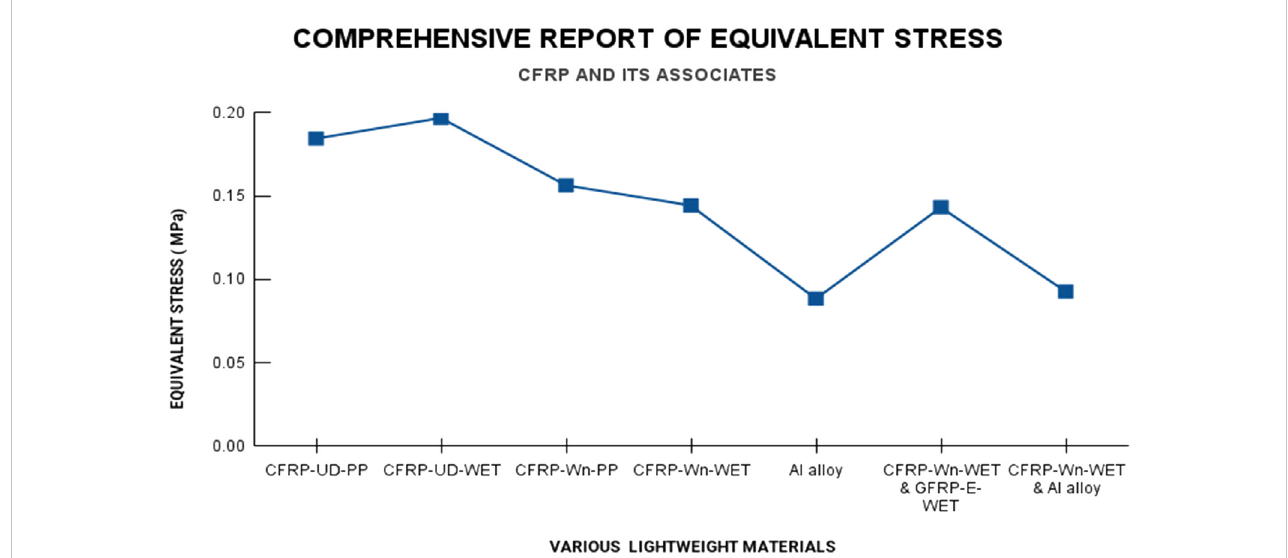
FIGURE 17 Equivalent stress on half fuselage of RUAV with CFRP and its associate materials.